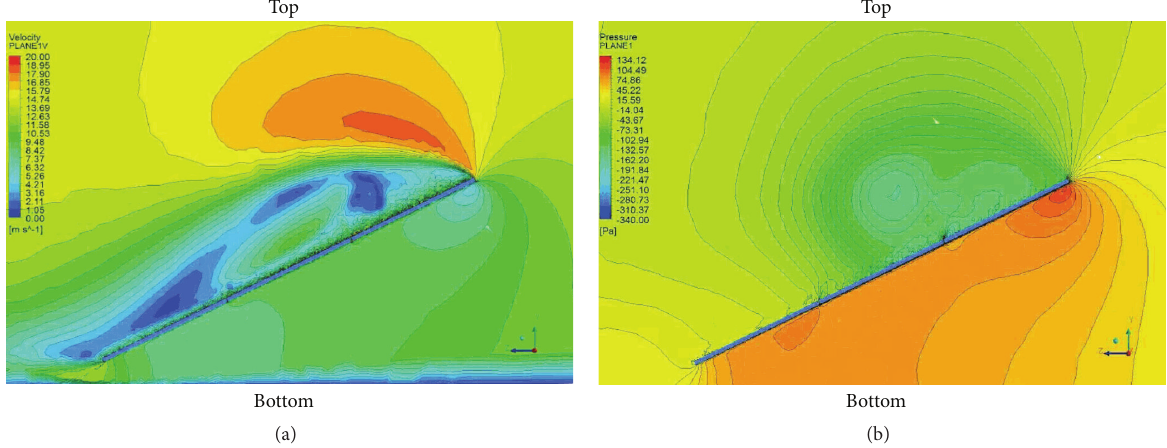
Figure 13: (a) Velocity magnitude (m/s) and (b) static pressure (N/m 2 ) contours at conventional panels, Section 1 , Figure 12, wind from right to left.